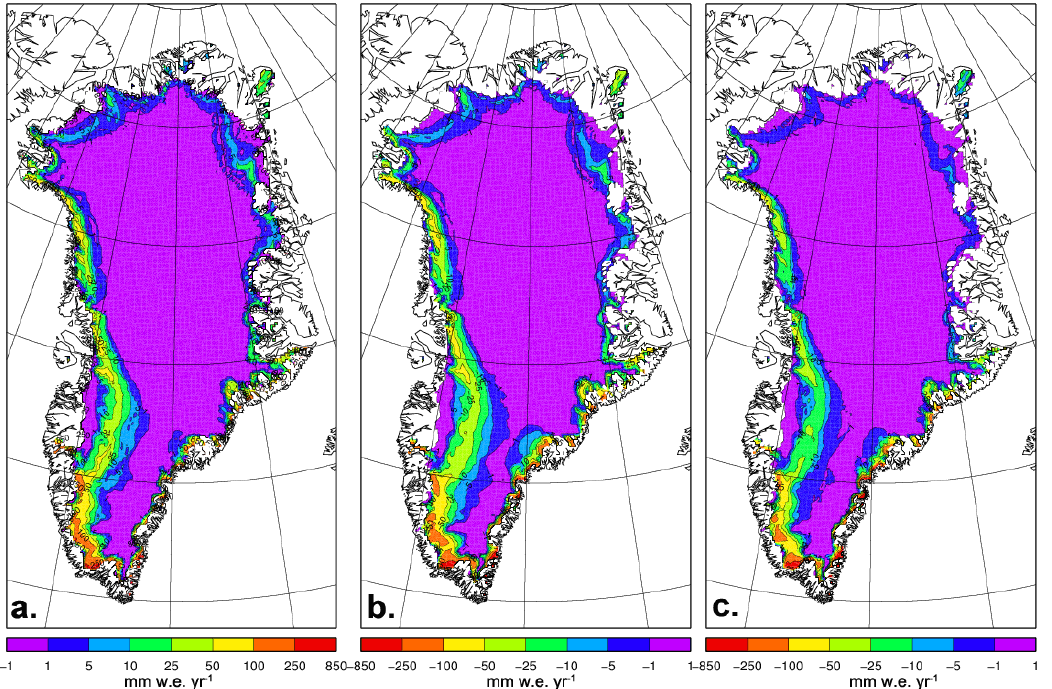
Fig. 11. Difference in refreezing when changing the density factor in JH2000 by changing ρ f = 300kgm − 3 (Eq. 5) to (a) ρ f = 150kgm − 3 , (b) ρ f = 450kgm − 3 , and (c) ρ f (T s ) (Reeh et al., 2005) (test minus reference), using RACMO2 input fields. Note the reversed color scales in panels (b) and (c)